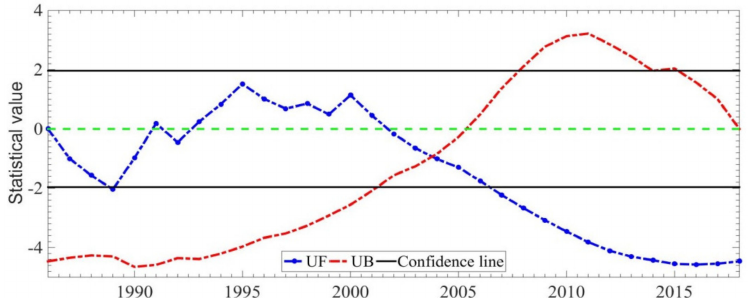
Figure 11. The trend of the annual mean lake area of the Ugii Nuur Lake (where UF and UB are parameters of the change, UB = − UF).